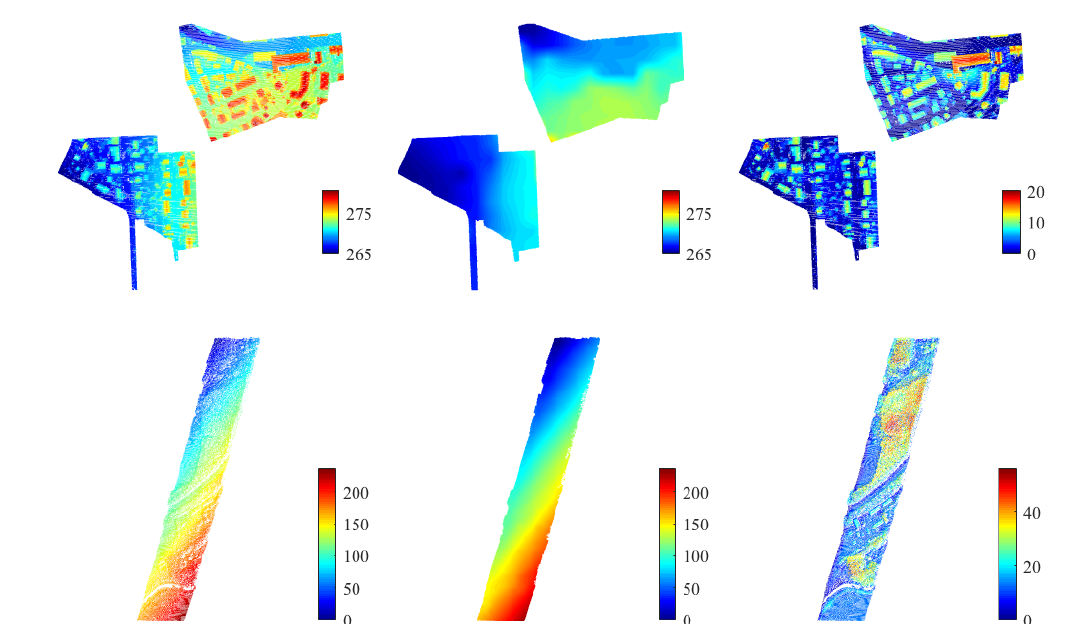
Figure 2. Effects of the scene topography. The point clouds’ height minima on a 0 . 5 m grid are shown on the left, the approximation of the scene topography is plotted in the middle, and the normalized minima are shown on the right. The top row depicts the test area of the Vaihingen Dataset , while the bottom row shows the test area of the GML Dataset A . Class